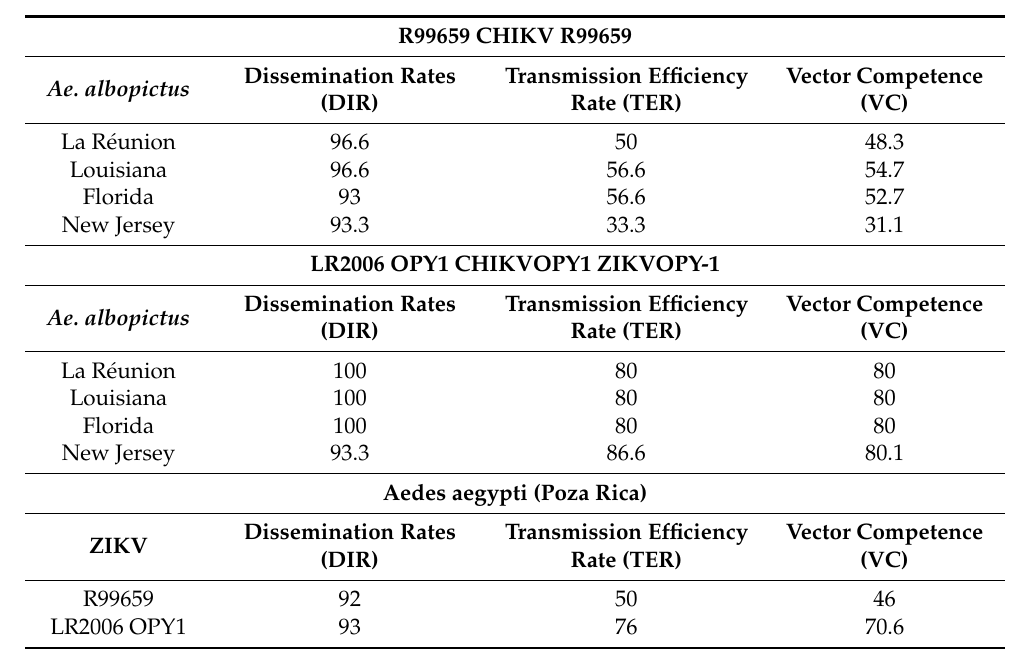
Table 1. DIR, TER, and vector competence for R99659 and LR2006 OPY1 CHIKVs and the four Ae. albopictus strains and one Ae. aegypti strain. n = 30 for all pairwise